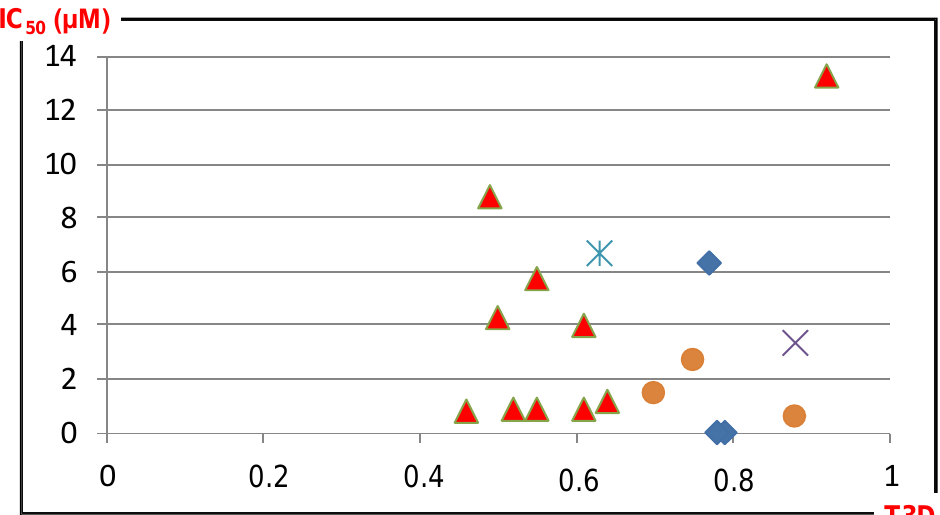
Figure 5. Correlation between PDE5 inhibitory activities and T3D values. (T3D: 3D similarity towards the first round hits).